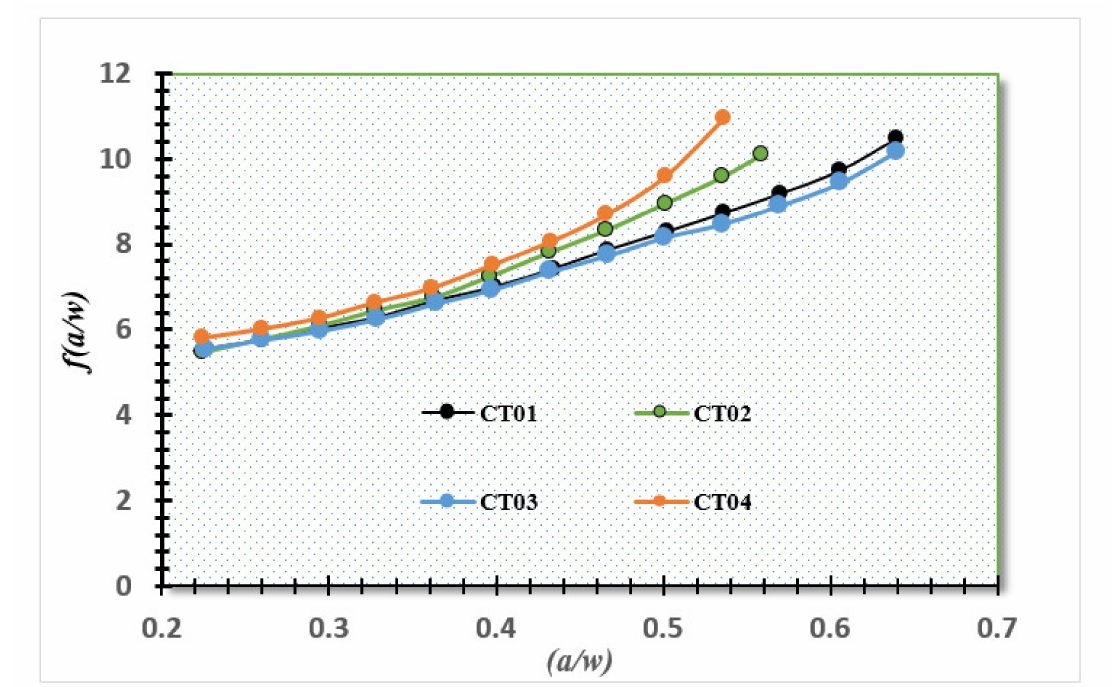
Figure 15. Dimensionless SIFs of di ff erent configuration of MCTS.